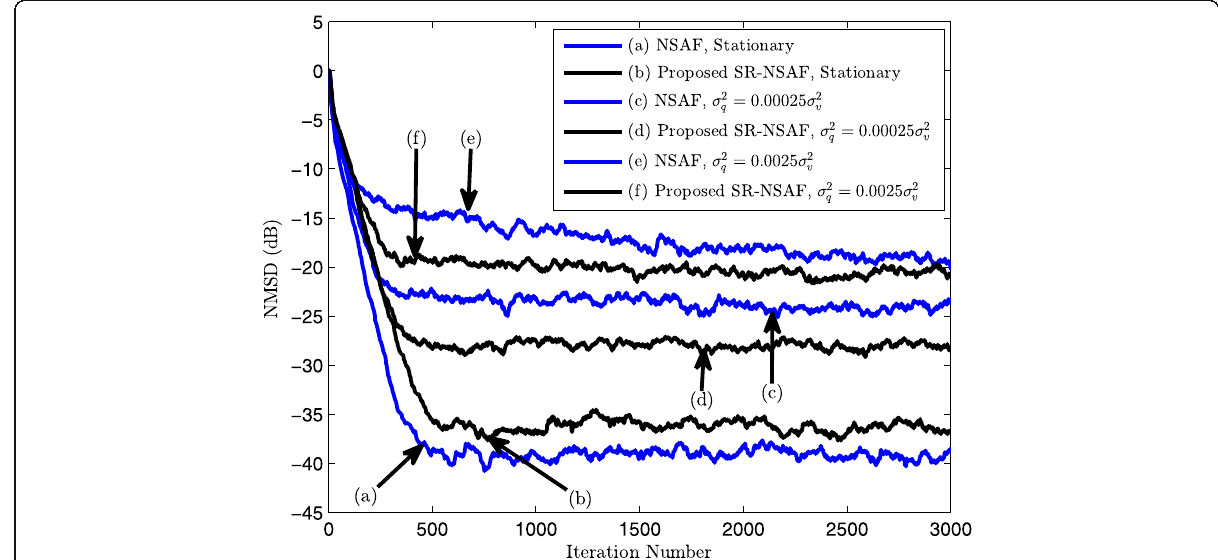
Fig. 17 NMSD learning curves of NSAF and SR-NSAF with N = 8 and μ = 0.5 in nonstationary environment for different values of σ 2